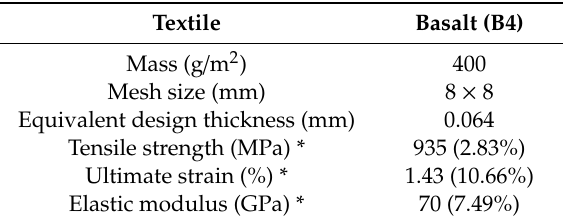
Table 2. Physical and mechanical properties of the textile. Textile Basalt (B4)